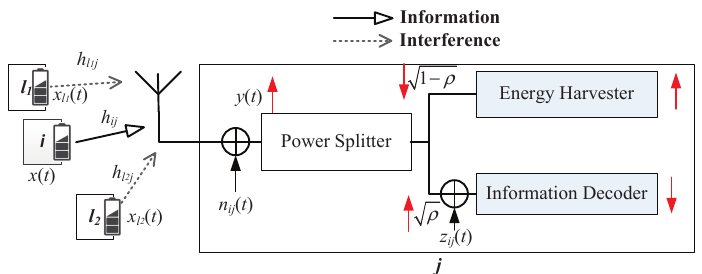
Figure 6. The various influences of interference on SWIPT. The interference reduces the quality of information transmission and becomes a source of